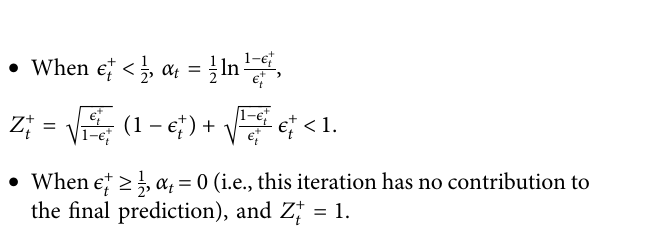
FIGURE 1 | The convergence of the DiffBoost algorithm. Training error of the rare class asymptotically converges to zero as its upper bound decreases monotonically.